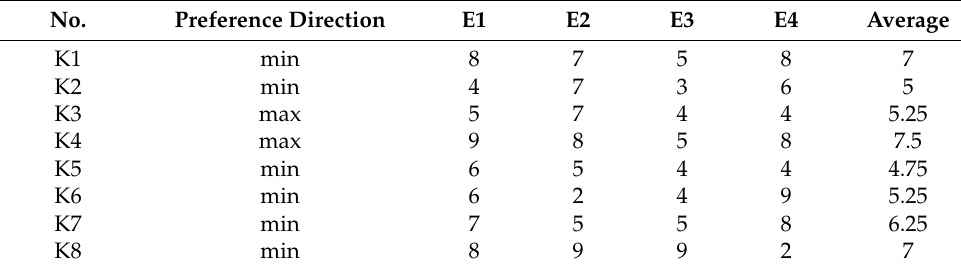
Table 8. Relative and average importance of the criteria considered by experts